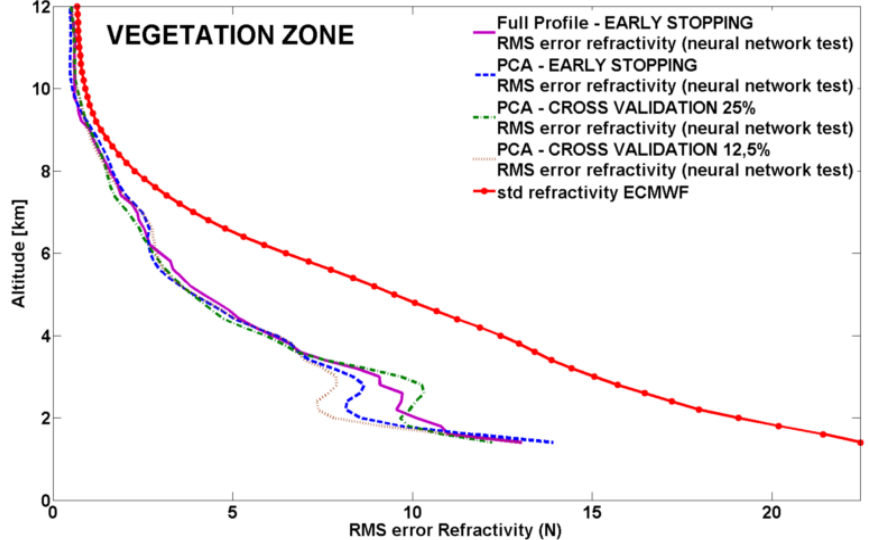
Figure 3. Vegetation zone, neural network independent test (35 occultations): RMS error profiles for N using the different neural network